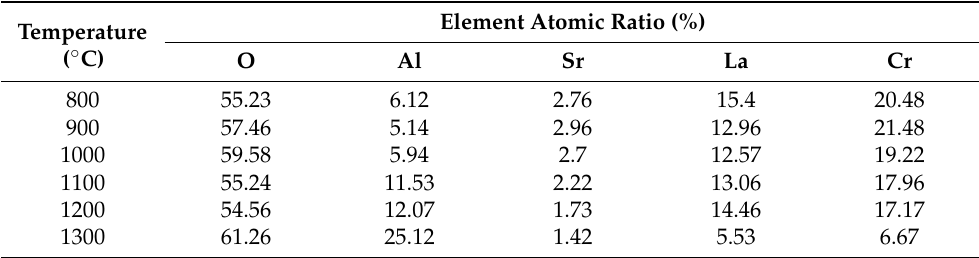
Table 1. Contents of main elements in 0.2LSCO thin films with different post-annealing tempera- tures.